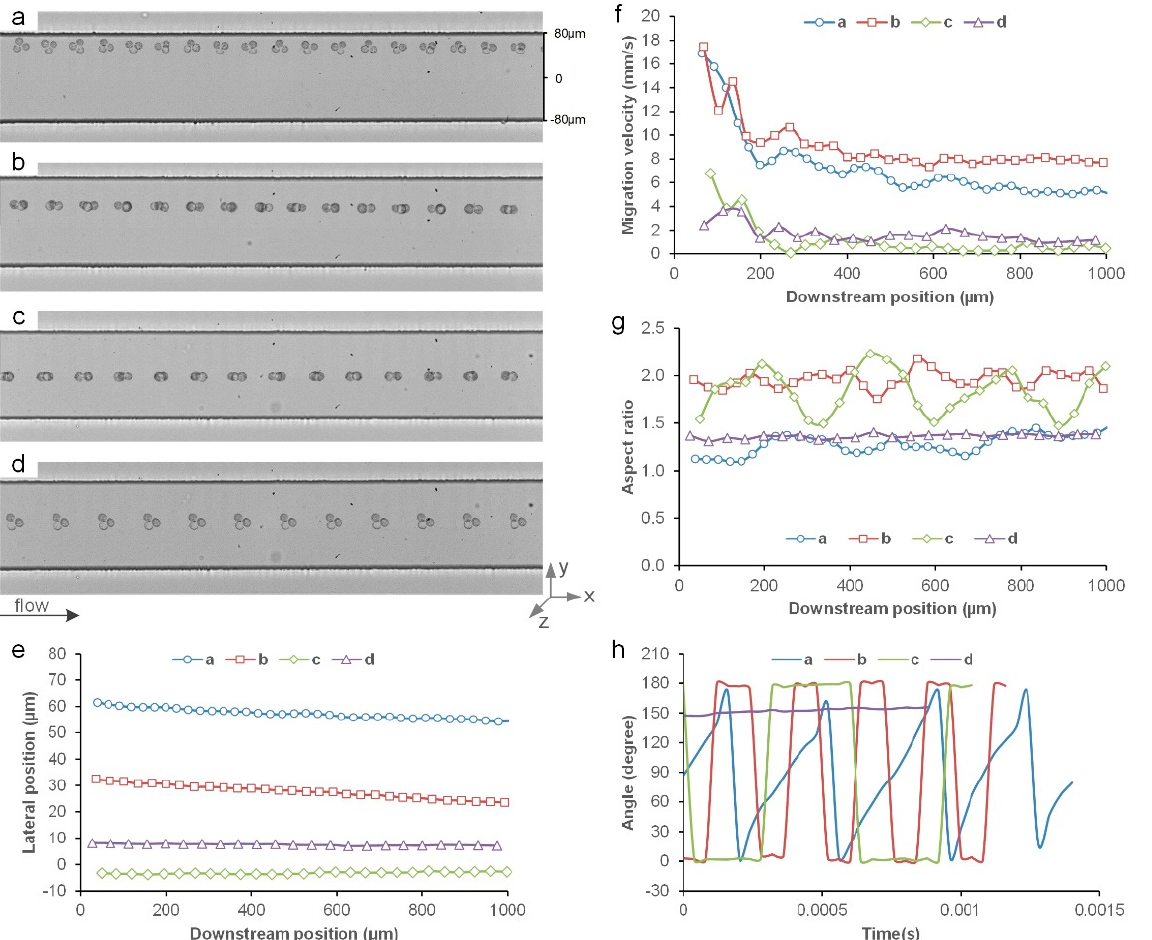
Figure 5. Inertial migration of triangle triplets: ( a ) A triangle triplet near channel sidewall migrates away from the wall while rotating about the z -axis; ( b ) A triangle triplet migrates fast toward the channel centerline while tumbling (rotating about y -axis); ( c ) A triangle triplet near channel centerline tumbling downstream (rotating about y -axis) with very small migration; ( d ) A triangle triplet with little rotation shows very small lateral migration; ( e – h ) The lateral displacement, lateral migration velocity, aspect ratio, and the rotation of the four doublets in ( a – d ). The bright-field images in ( a – d ) are stacked every two frames to show the trajectories of the